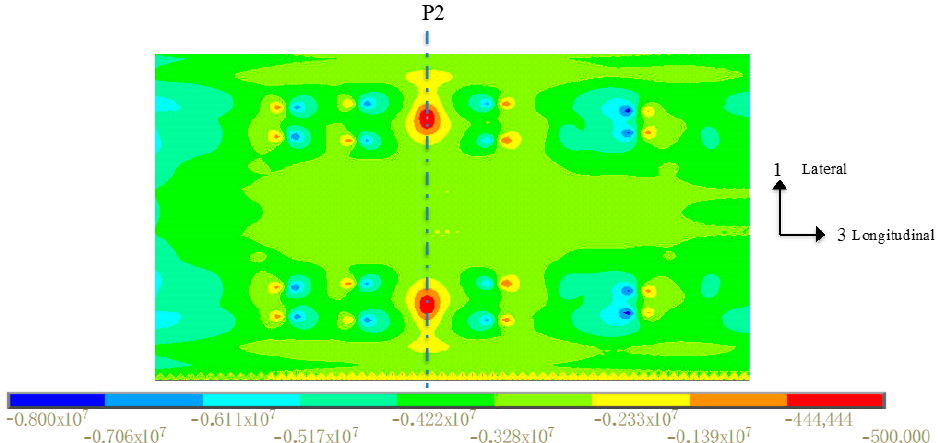
Figure 7. Stress at the top surface of the concrete deck in the hogging region after 10,000-day creep (Pa).